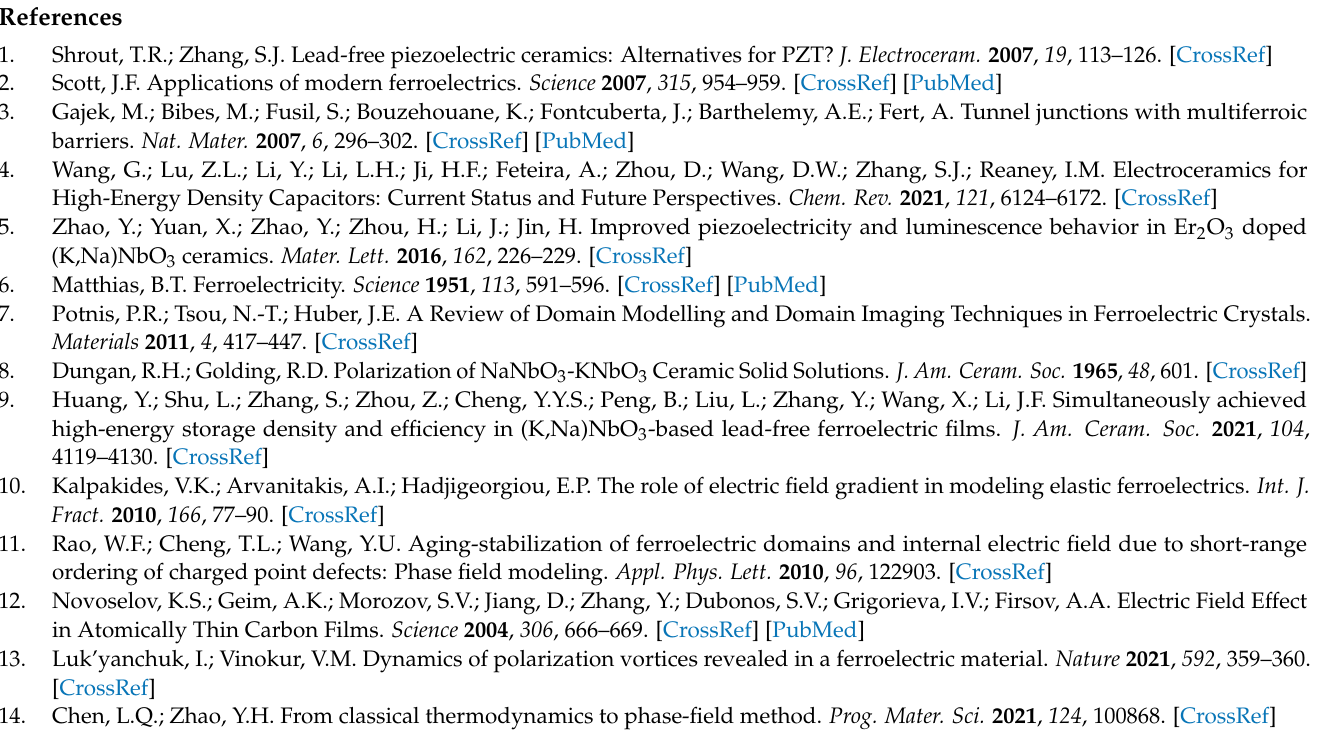
different electric conditions. (a) without electric field; (b, c) loading electric field; (d, e) unloading electric field.; Figure S3: Dynamic temporal evolution of the volumetric average intrinsic energy density (consisting of Landau, gradient, and elastic energy density) and the average electrostatic energy density under different electrical conditions in KNbO 3 thin films. The 0–1500 time steps represent the loading process while the 1500–3000 represent the unloading process. (a) Landau and intrinsic energy density. (b) Electrostatic energy density. (c) Gradient energy density. (d) Elastic energy density.; Figure S4: Dynamic temporal evolution of the volumetric average intrinsic energy density (consisting of Landau, gradient, and elastic energy density) and the average electrostatic energy density under different electrical conditions in K 0.75 Na 0.25 NbO 3 thin films. The 0–1500 time steps represent the loading process while the 1500–3000 represent the unloading process. (a) Landau and intrinsic energy density. (b) Electrostatic energy density. (c) Gradient energy density. (d) Elastic energy density.; Table S1: Related coefficients for K 1 − x Na x NbO 3